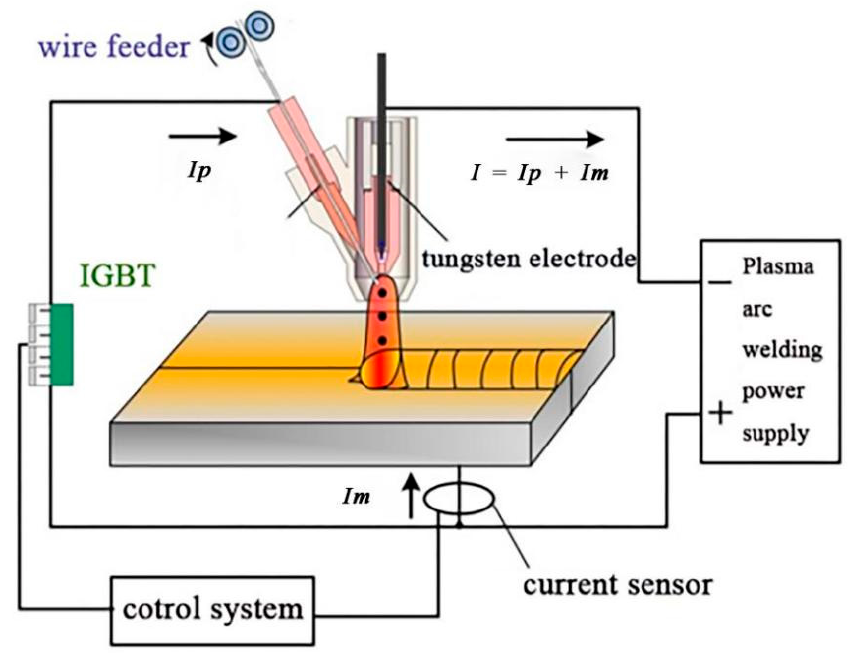
Figure 1. Schematic diagram of titanium alloy bypass current hot wire plasma arc welding. Table 1. Chemical composition of TC4 alloy and Table 2. Experimental parameters used in this study.